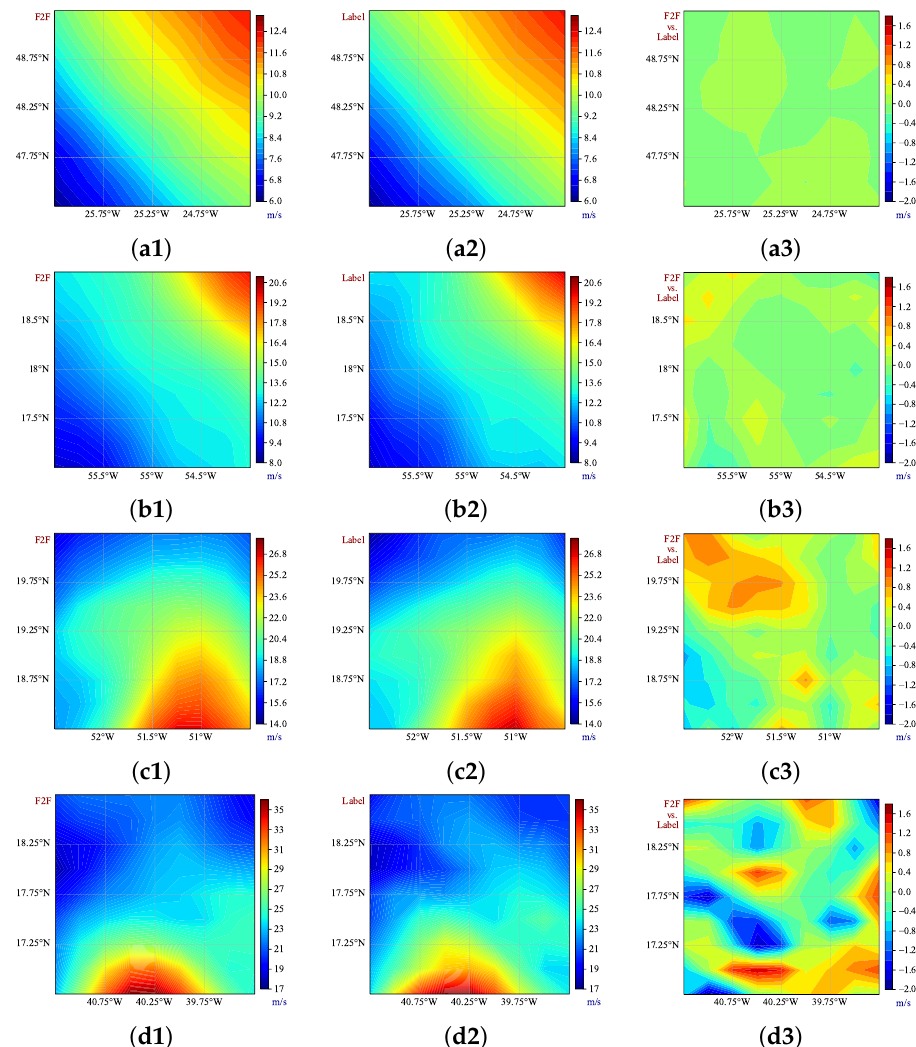
Figure 6. ( a1 – d1 ) shows F2F-NN wind fields in different wind speed ranges, ( a2 – d2 ) shows label wind fields, and ( a3 – d3 ) shows the difference between the F2F-NN wind and label